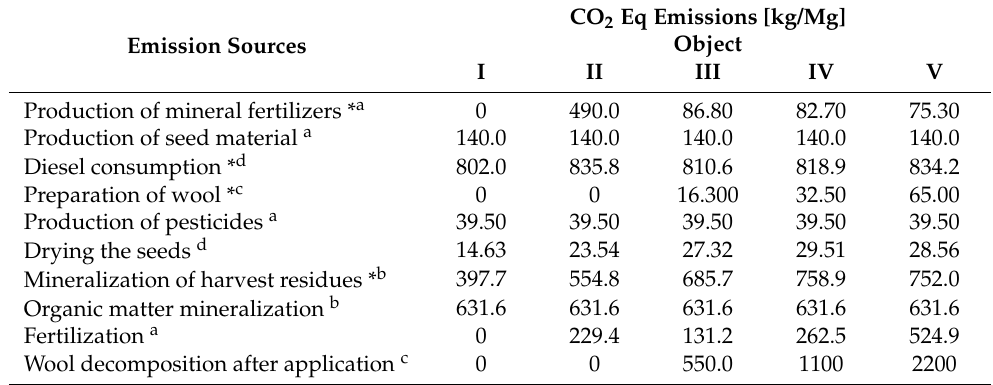
Table 7. CO 2 emissions from fertilizers (CO 2 equivalent/1 t of dry bean